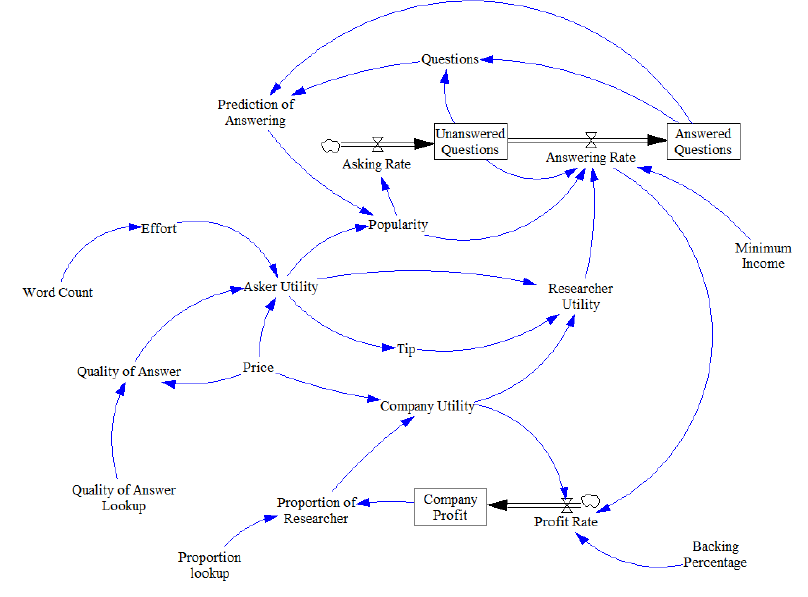
Fig. 2. Stock-flow diagram of locking and answering behavior